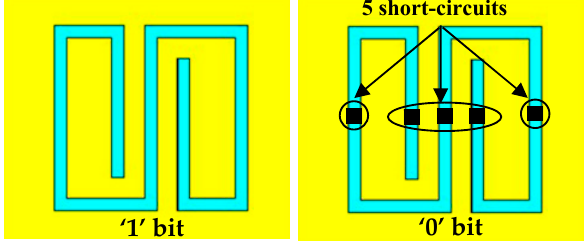
Figure 3. To encode a 0 bit, five short-circuits are used to modify the layout of the single resonator.